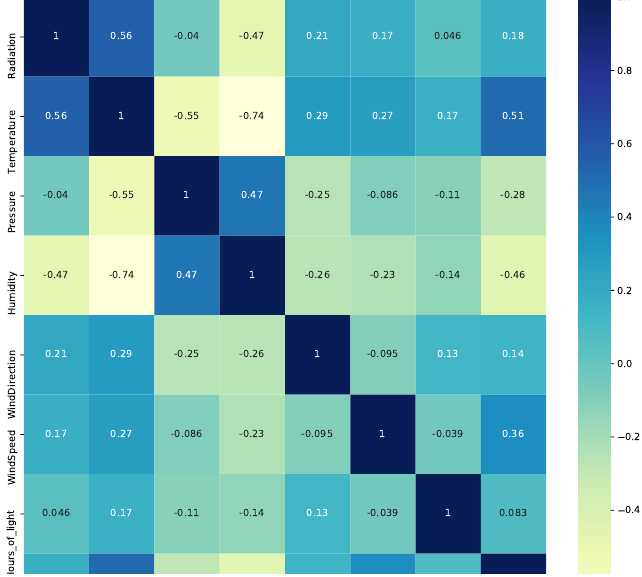
Figure 5. Correlation matrix plot for the all the weather variables.